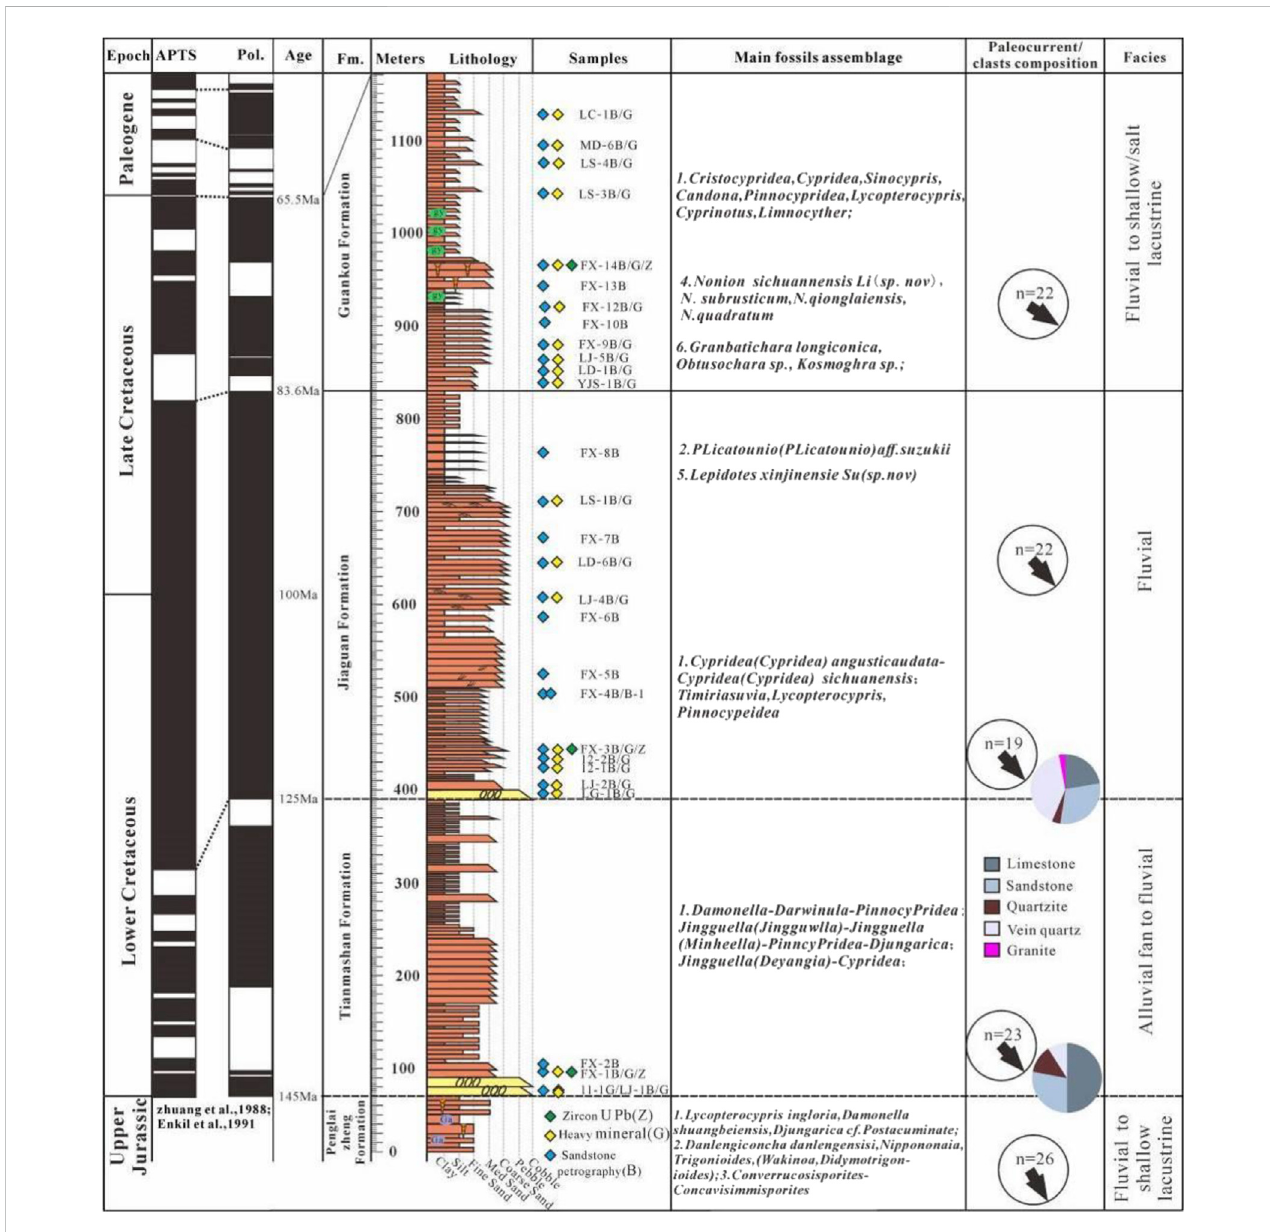
FIGURE 3 ComprehensivestratigraphiccolumnoftheCretaceousintheSWSichuanBasin,indicating thepositionofanalyzedsamples,andupwardcompositional variations in conglomerates. The geomagnetic polarity time scale (GPTS) is from Harland et al. (1982), and the observed polarity data are from Zhuang et al. (1988), Enkin et al. (1991). Fossil data are compiled from BGMRSP (1991), Wei (1979), Ye (1983), Chen (1983), Su (1983), Li (1987), Gou (1998) and Wang et al. (2006). 1 Ostracoda; 2 Lamellibranchia; 3 Pollen; 4 Foraminifera; 5 Fish; 6